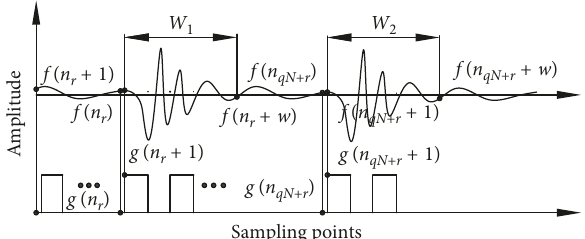
Figure 9: Acquisition principle of W areas. f n sponding to g r + 1 ) is selected as the starting point, and ( are intercepted backward as W